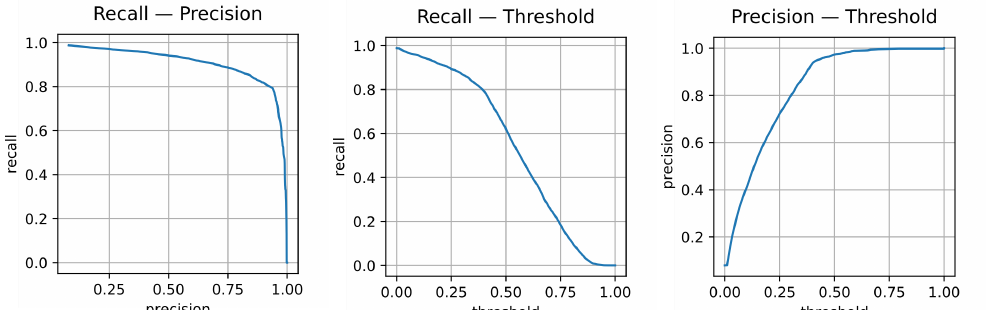
Figure 4. Precision and recall of bicycle detections in relation to the confidence threshold θ s : the first graph shows the recall–precision curve, while the second and third graphs represent the relationships of recall and precision to the confidence threshold separately.